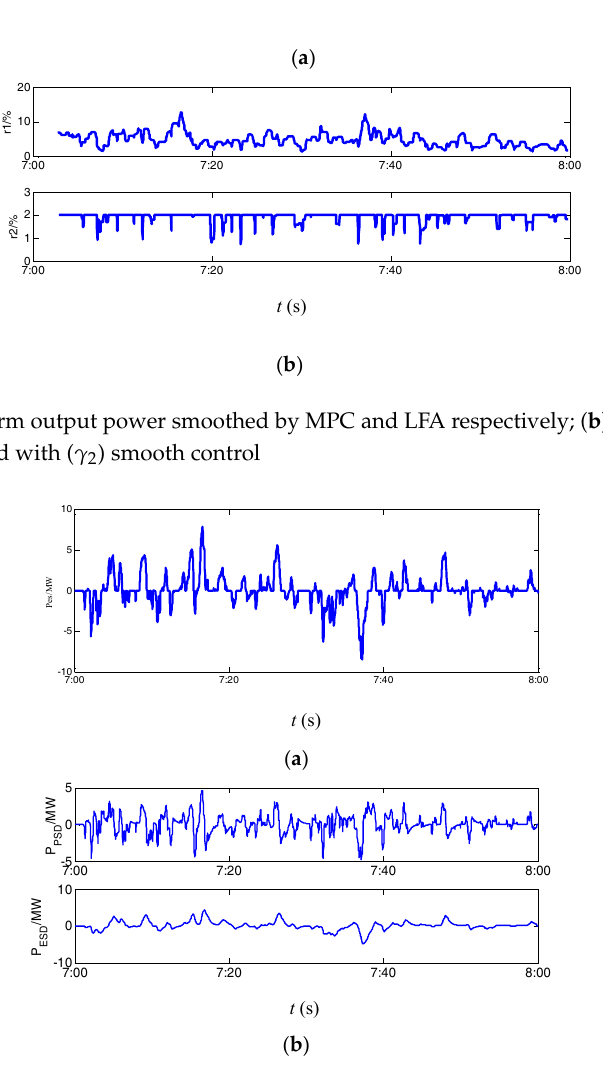
Figure 7. ( a ) Power profile P es of the total energy storage system; ( b ) Power profile of PSD ( P PSD ) and ESD ( P ESD ).